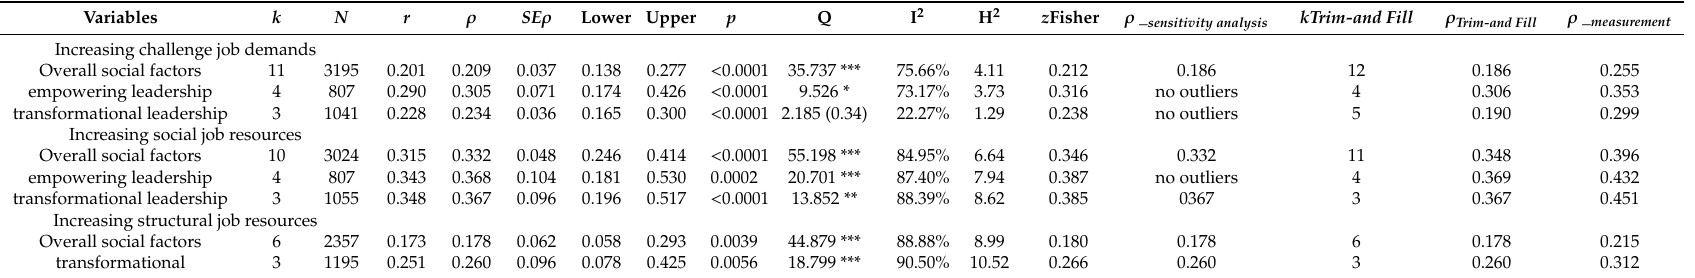
Table 2. Summary of meta-analytic relationship: social factors as correlates of specific job crafting behaviors (H1).